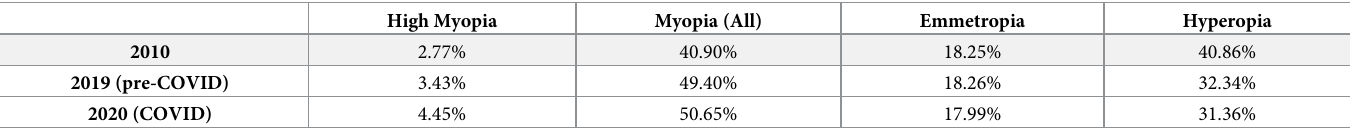
Table 3. Percentage of refractive error type in the first and last years of